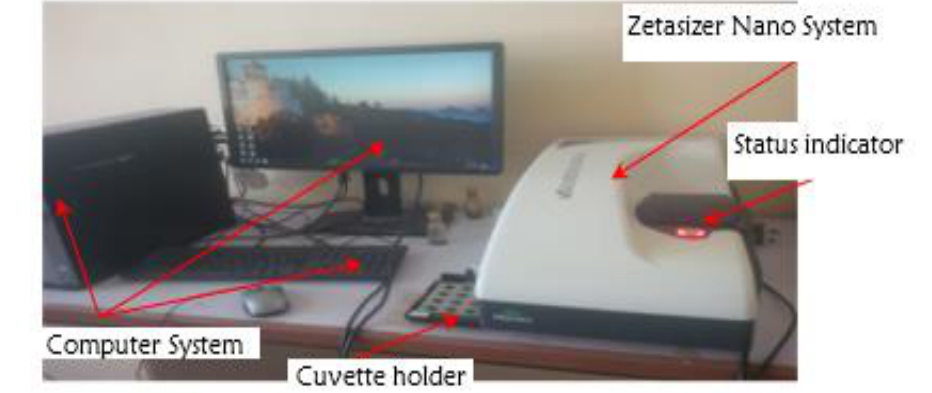
Figure 3: Particle Size